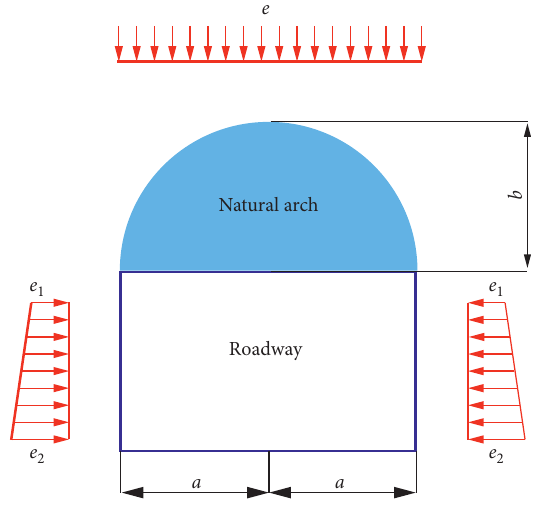
Figure 5: Natural arch theory